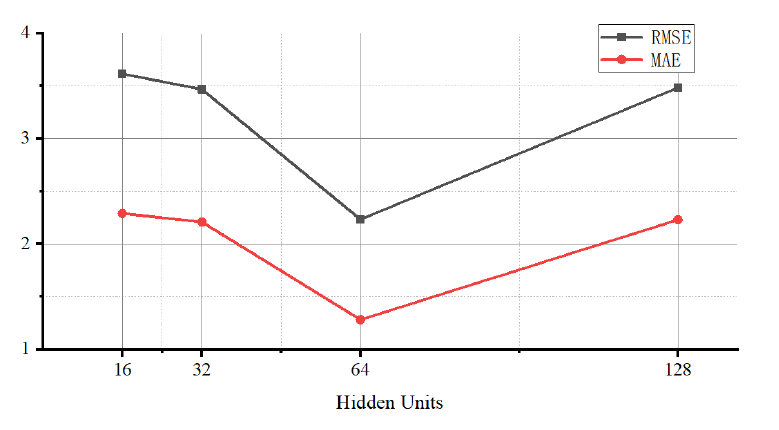
Figure 10. Comparison of prediction performance under different hidden